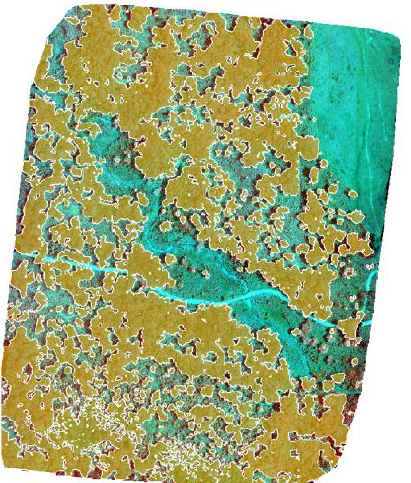
Figure 5. Result of contrast split